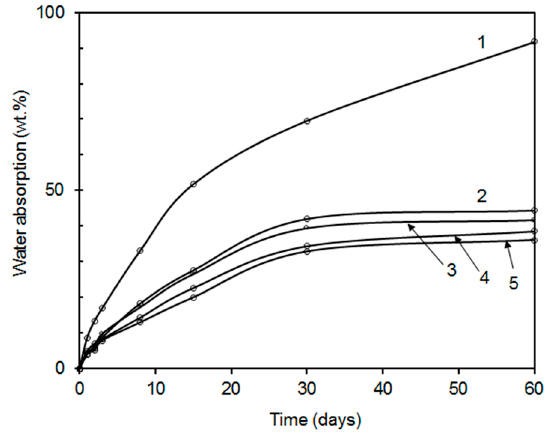
Figure 7. Water absorption into coating films prepared from the latexes containing ZnO-based nanoparticles: sample L 0 without nanoparticles (curve 1); sample L ZnO-0.5 (curve 2); sample L ZnO-1.0 (curve 3); sample L ZnO-1.5 (curve 4); sample L ZnO-2.0 (curve 5). The standard deviations of performed measurements were below 2%.